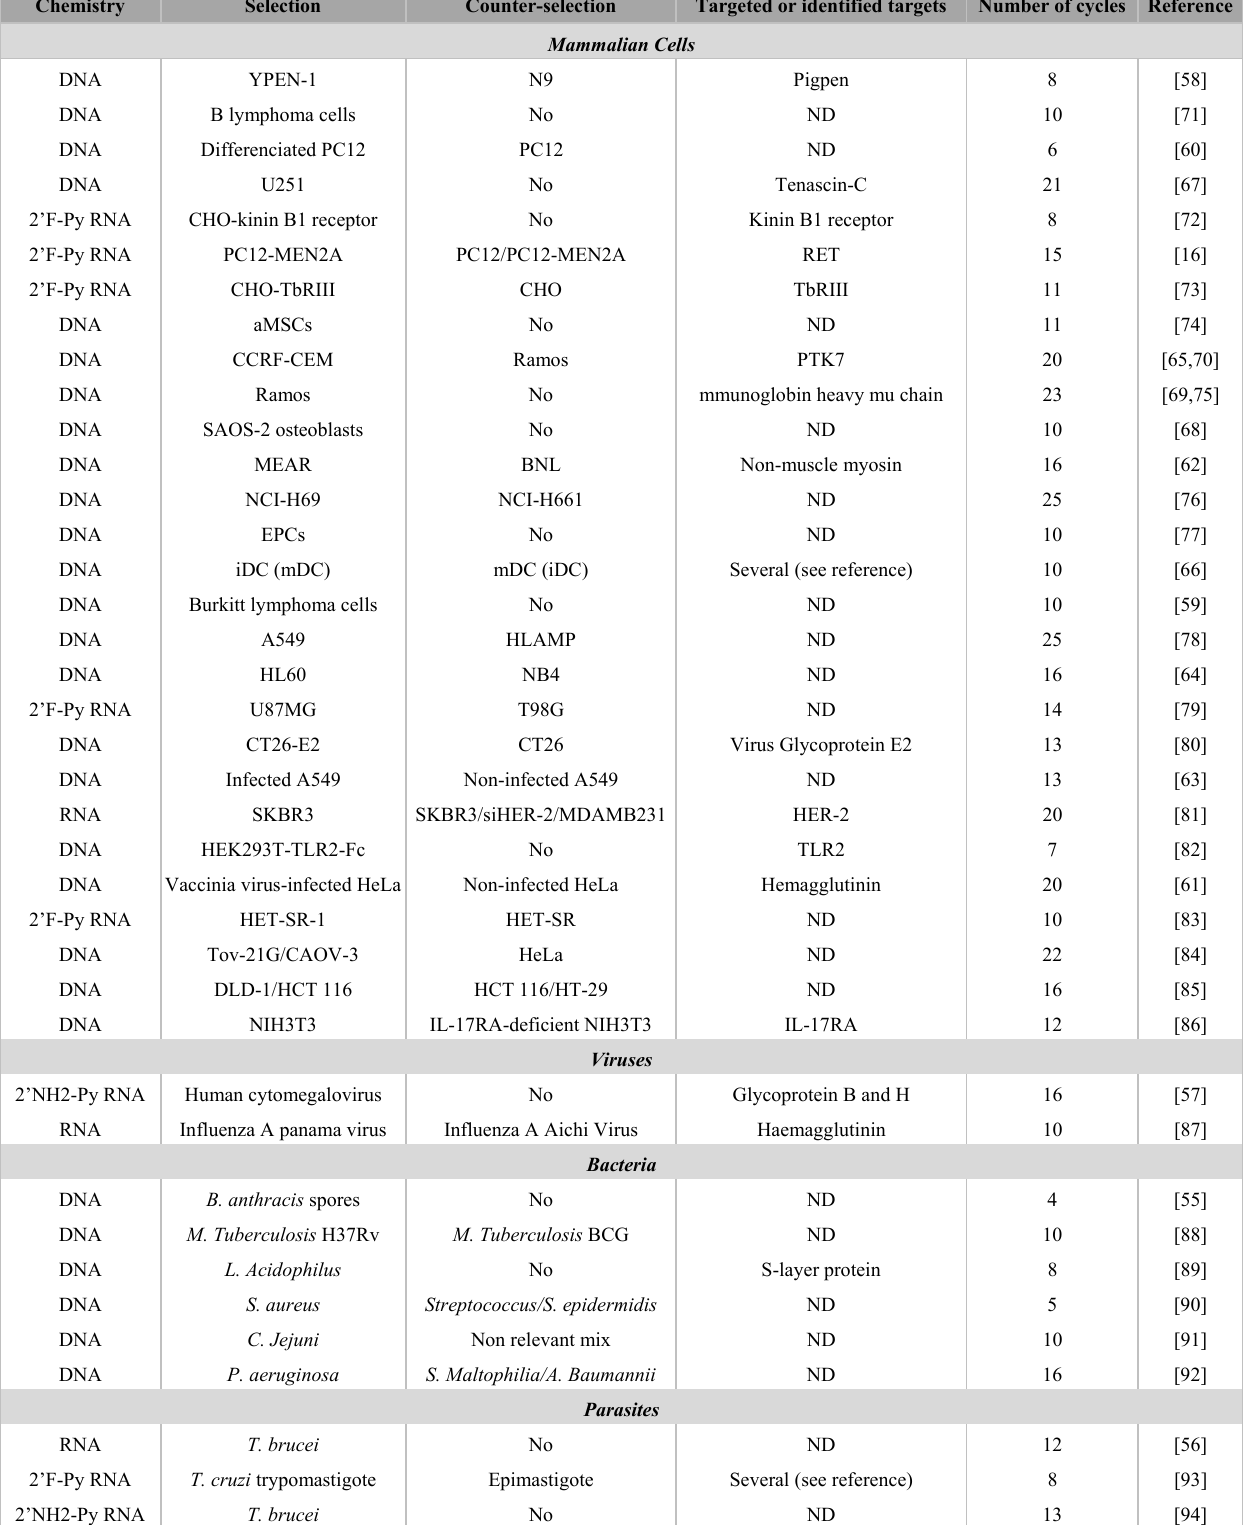
Table 3. SELEX directed against whole living